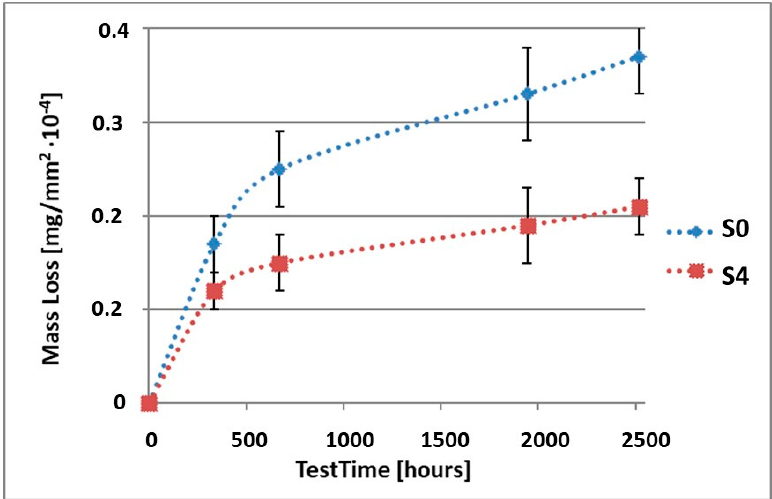
Figure 3. Comparison of the mass losses of samples S0 and S3 for tests in NSS environment.